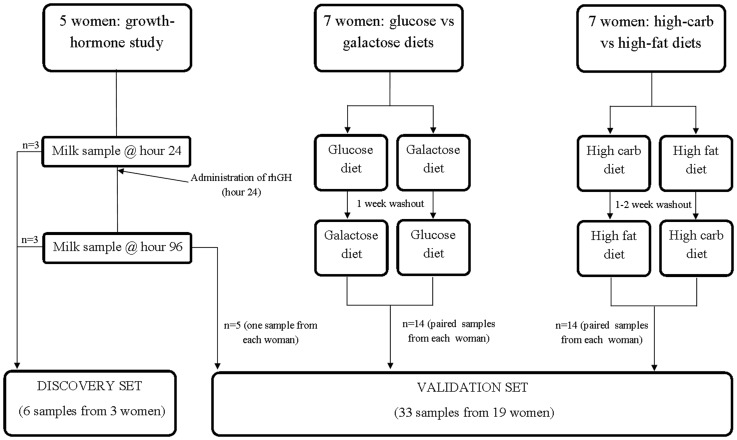
Flowchart outlining the acquisition of breast milk samples into sets for discovery, interrogation and validation.Each of these cohorts has been previously described and well-characterized [7], [27], [32]. Briefly, in the discovery set lean healthy women received weight-based recombinant human growth hormone for synchronization at 24 hours of study initiation for synchronization. The women continued to collect breast milk via pump every 3 hours for an additional 48 hours, and every 4 hours thereafter for a total of 96 hours studied. Breast milk samples used for the discovery set were collected at hour 24 and hour 96 (2 samples from each of 3 women, for a total of 6 samples). To both confirm and ascribe potential functional significance, two dietary manipulations were additionally employed in the validation set. These two cohorts were part of two crossover studies (whereby each subject serves as her own control following random sequence allocation) examining the effects of diet composition on milk quality, quantity, and carbohydrate expenditure. In the glucose-galactose cohort [27], 7 obese subjects consumed a diet of 15% protein, 50% carbohydrate, and 35% fat under controlled GCRC conditions. After an overnight fast, women were randomized to receive an isocaloric drink every 3 hours comprised of either glucose or galactose, the sugars in which provided them with 60% of their daily estimated energy requirement. In the high carbohydrate-high fat cohort [32] 7 lean subjects were randomly assigned to either a high-carbohydrate, low fat diet (60% carbohydrate, 25% fat, and 15% protein), or 2) a low-carbohydrate, high-fat diet (30% carbohydrate, 55% fat, and 15% protein), the caloric value of which was tailored to the woman’s required total energy intake (1.3 times basal metabolic rate). Breastfeeding occurred every 3 hours followed by milk expression via electric pump.